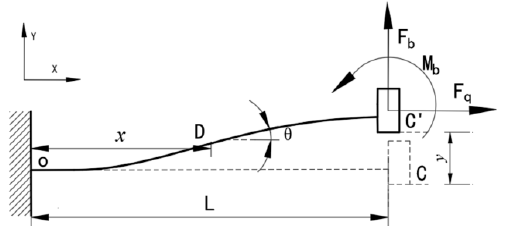
Figure 2. Analysis of the mechanics of a guided flexure beam.